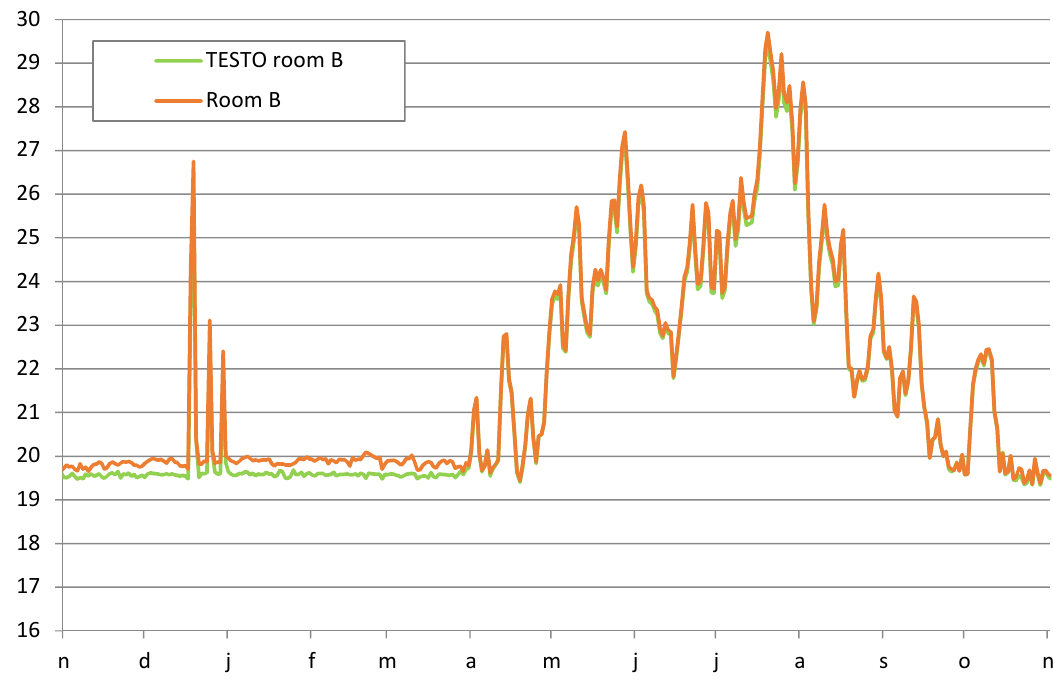
Figure 10. Daily mean indoor temperatures in room A, as measured by the ventilation system (Room A) and by the TESTO device (TESTO Room A).